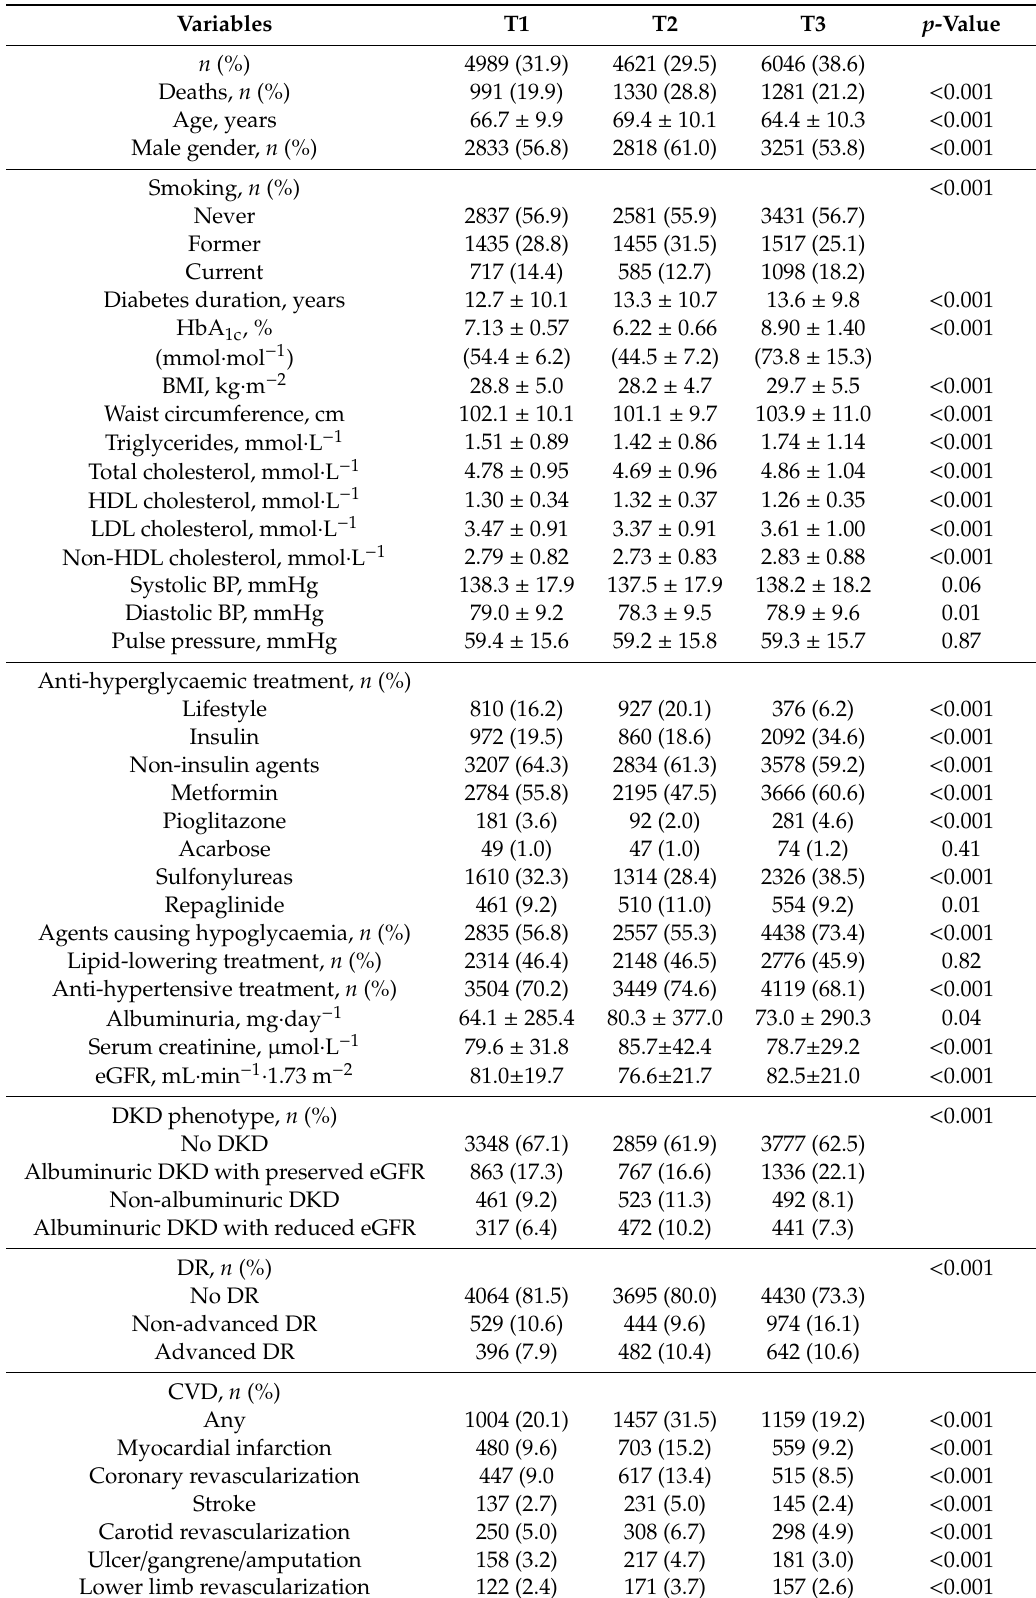
Table 3. Baseline clinical features of study participants by HbA 1c target